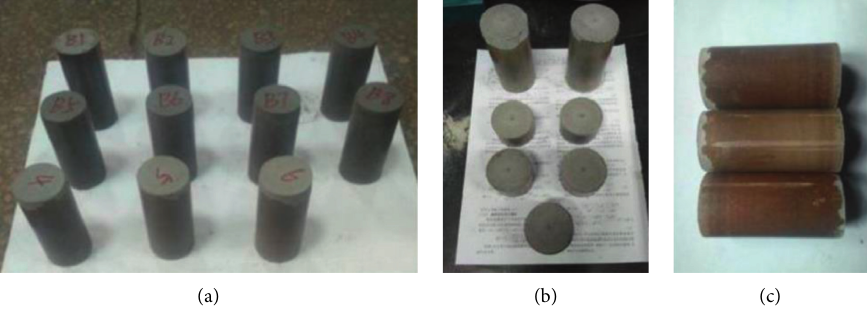
Figure 2: Prepared partially remoulded specimen.